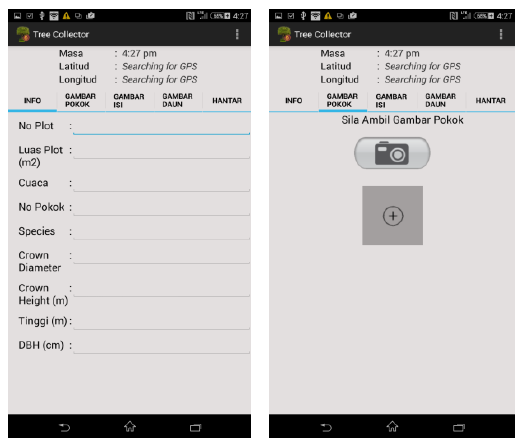
Figure 2. The User interface of GeoTrees mobile application